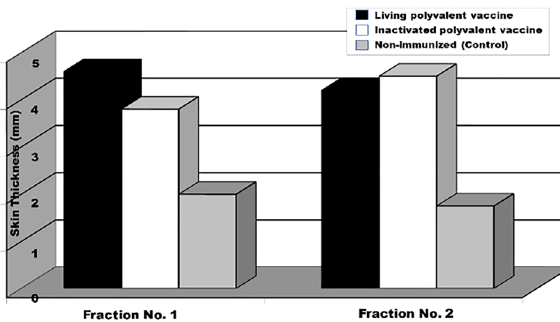
Figure 7. Delayed Skin reaction to dermatophyte exo-keratinase antigens (Fraction I and II) in guinea pigs immunized with the living or the inactivated non-adjuvanted polyvalent dermatophyte